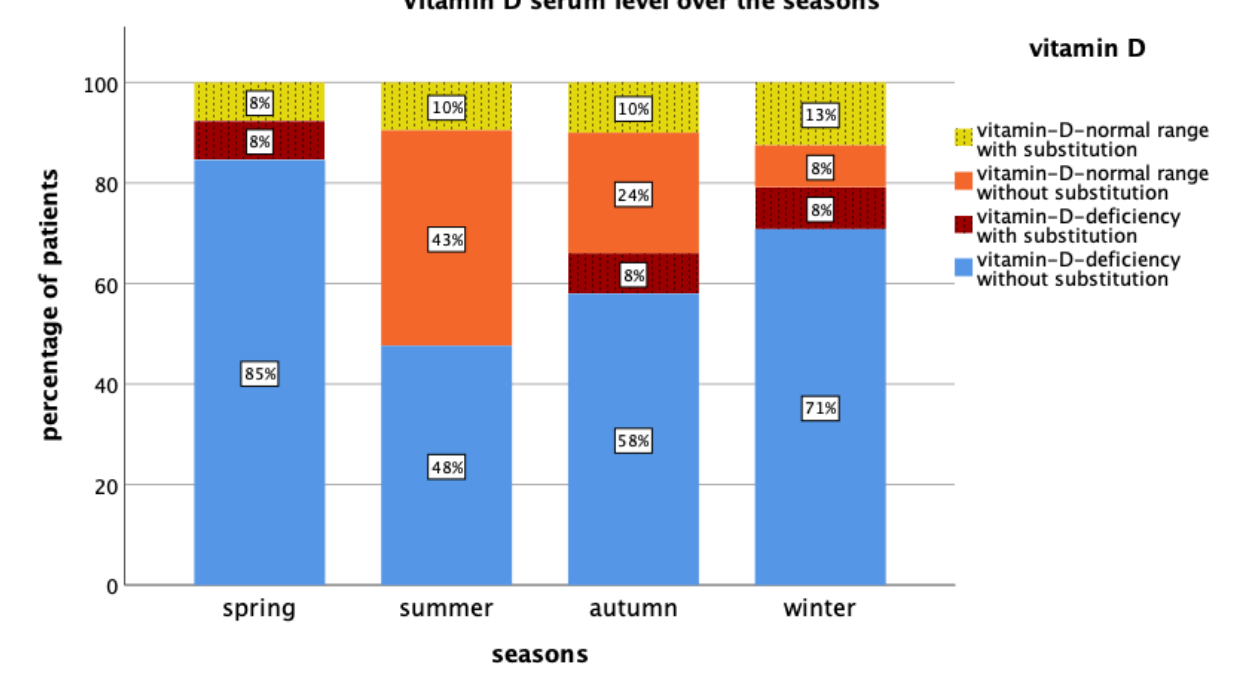
Figure 2. Serum 25-hydroxyvitamin D (25(OH)D) levels throughout the seasons with and without vitamin D substitution. Median vitamin D levels in spring (March, April, May) 20 ng/mL, summer (June, July, August) 31 ng/mL, autumn (September, October, November) 25 ng/mL and winter (December, January, February) 17 ng/mL. (Reference for standard vitamin D values: 30–100 ng/mL).